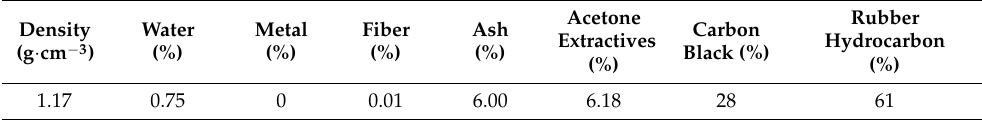
Table 2. The main technical indexes of crumb rubber.